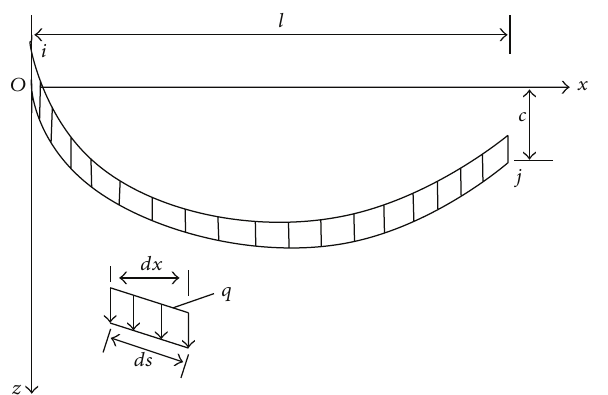
Figure 2: Coordinates of a single cable under self-weight.